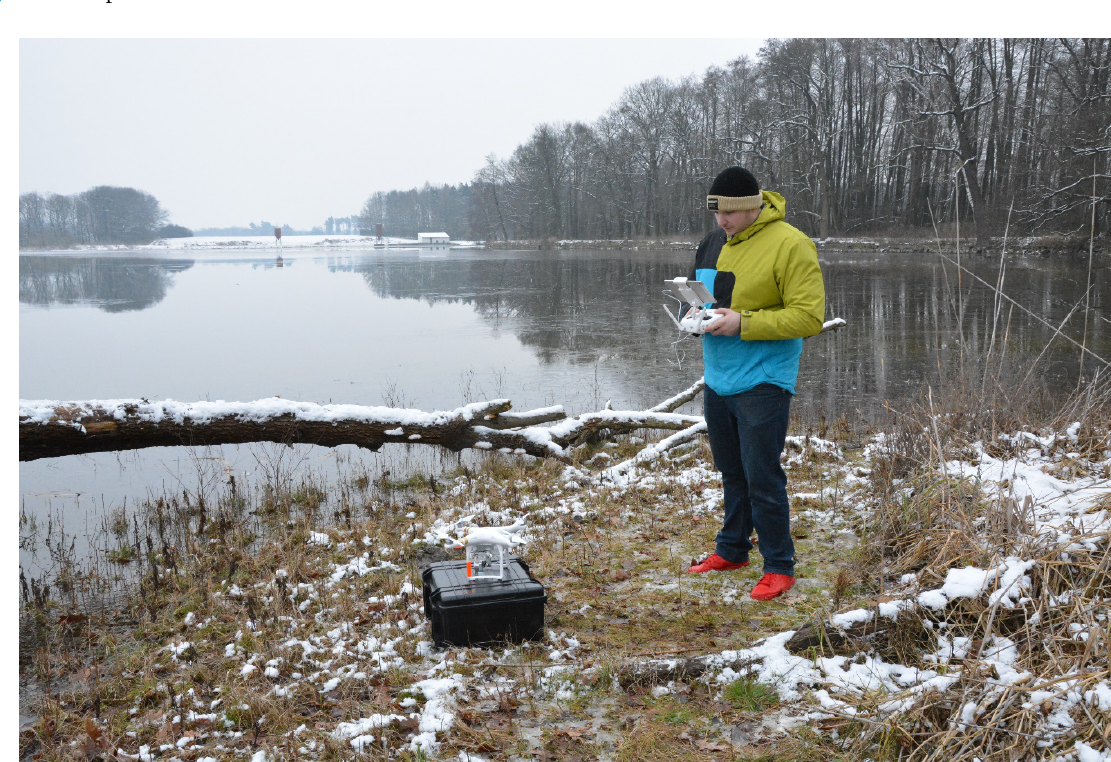
Figure 1. Map of the area of interest